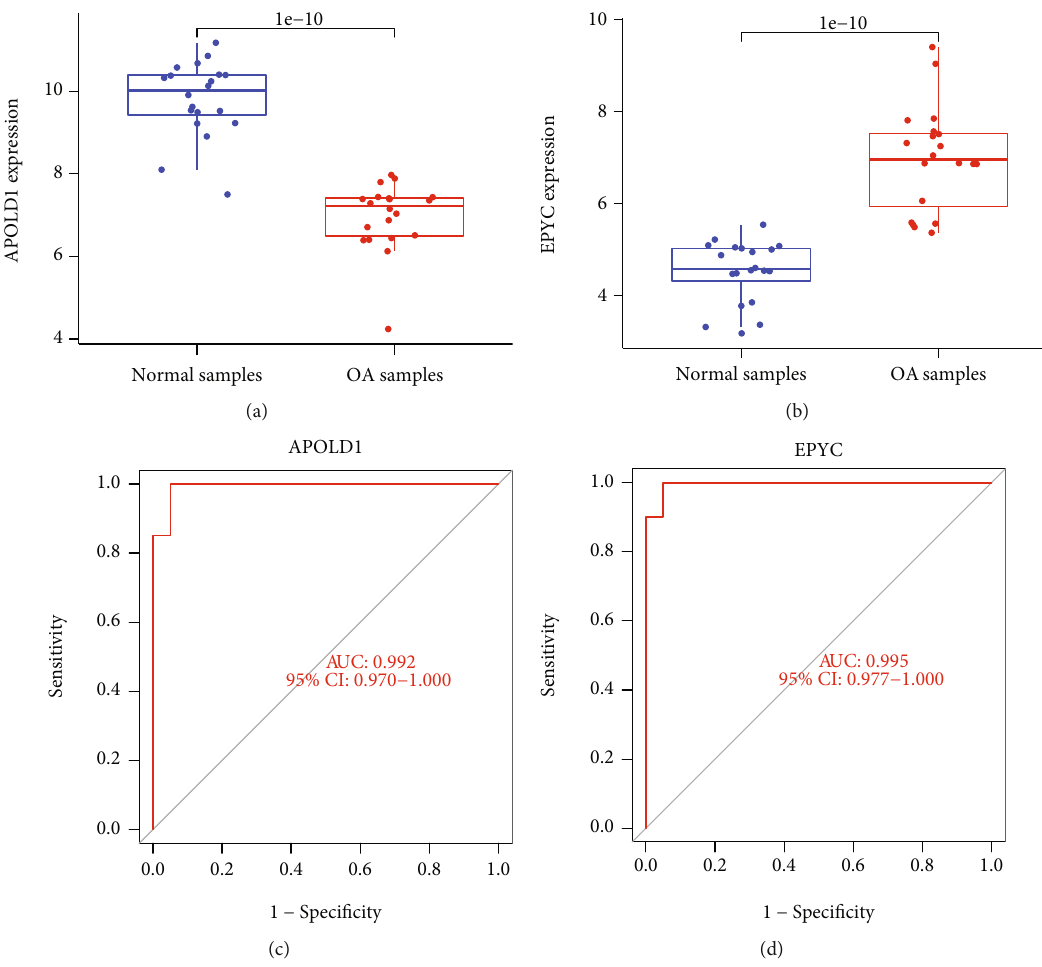
Figure 4: The expression and diagnosis signi fi cance of APOLD1 and EPYC in OA: (a) APOLD1 expression was distinctly downregulated in OA samples; (b) EPYC expression was distinctly upregulated in OA samples; (c, d) ROC assays for APOLD1 and EPYC in